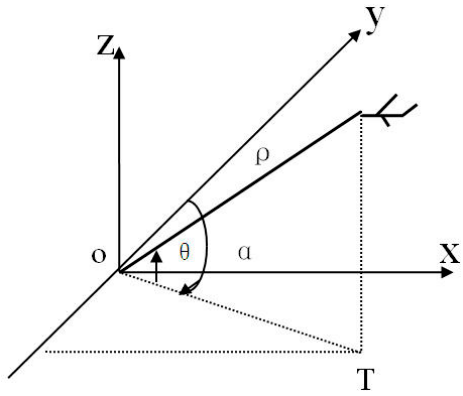
Figure 1. Coordinates of a single radar target.